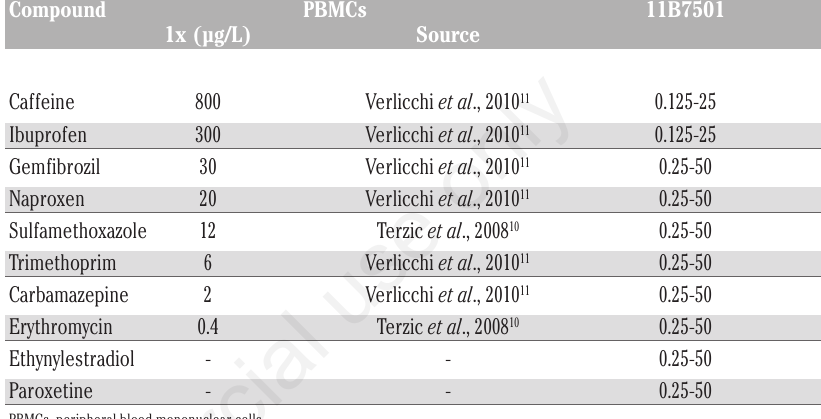
Table 1. Concentration range of pharmaceutical compounds tested with PBMCs and the 11B7501 cell line. For the experiments with PBMCs, test concentrations of single sub- stances were chosen according to values found in municipal effluents. The maximum value found in literature was set to be the 1x concentration. Further concentrations test- ed were 0x, 0.01x, 0.1x, 10x and 100x of the 1x value. Concentration ranges of the sin- gle substances for the experiments with the 11B7501 cell line were then increased.